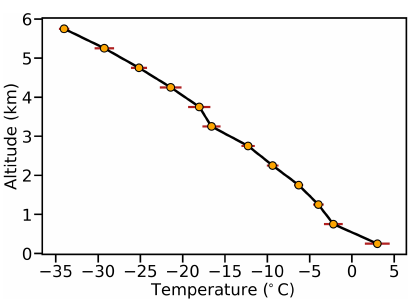
Figure 7. A temperature profile composited from aircraft in situ data during 06:00–09:00UTC on 13 February 2018. Data between 06:33:30–06:39:20UTC were unphysical and thus excluded. The error bars represent 1 standard deviation of sampled